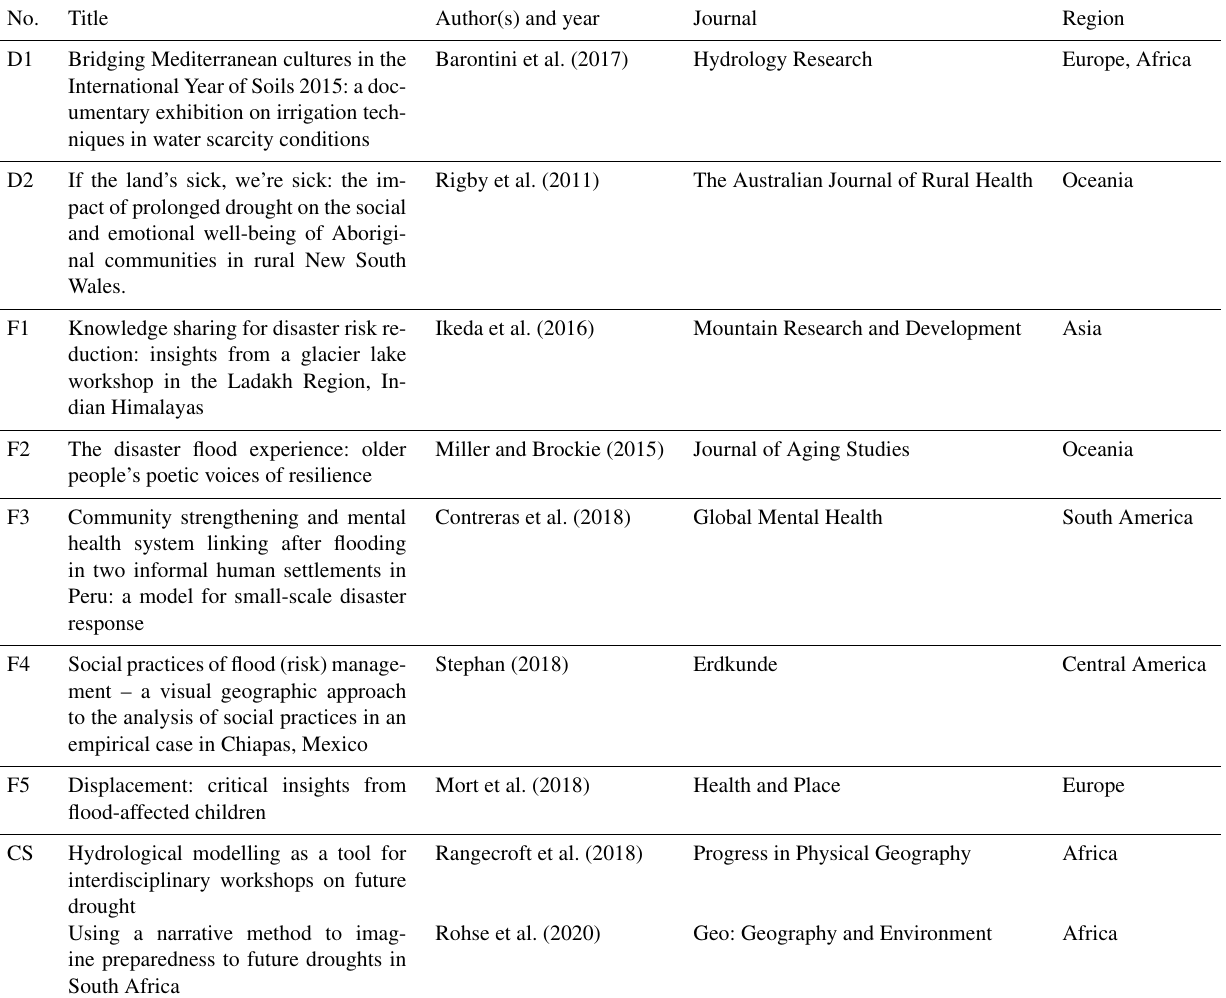
Table 1. Papers on drought (D1 and D2) and flooding (F1–F5) found in the literature-mapping exercise, focusing on creative practice and Global South communities, and the case study (CS) described in Sect.